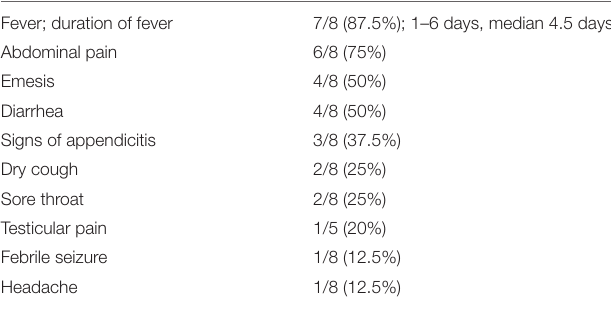
TABLE 2 | Clinical symptoms at